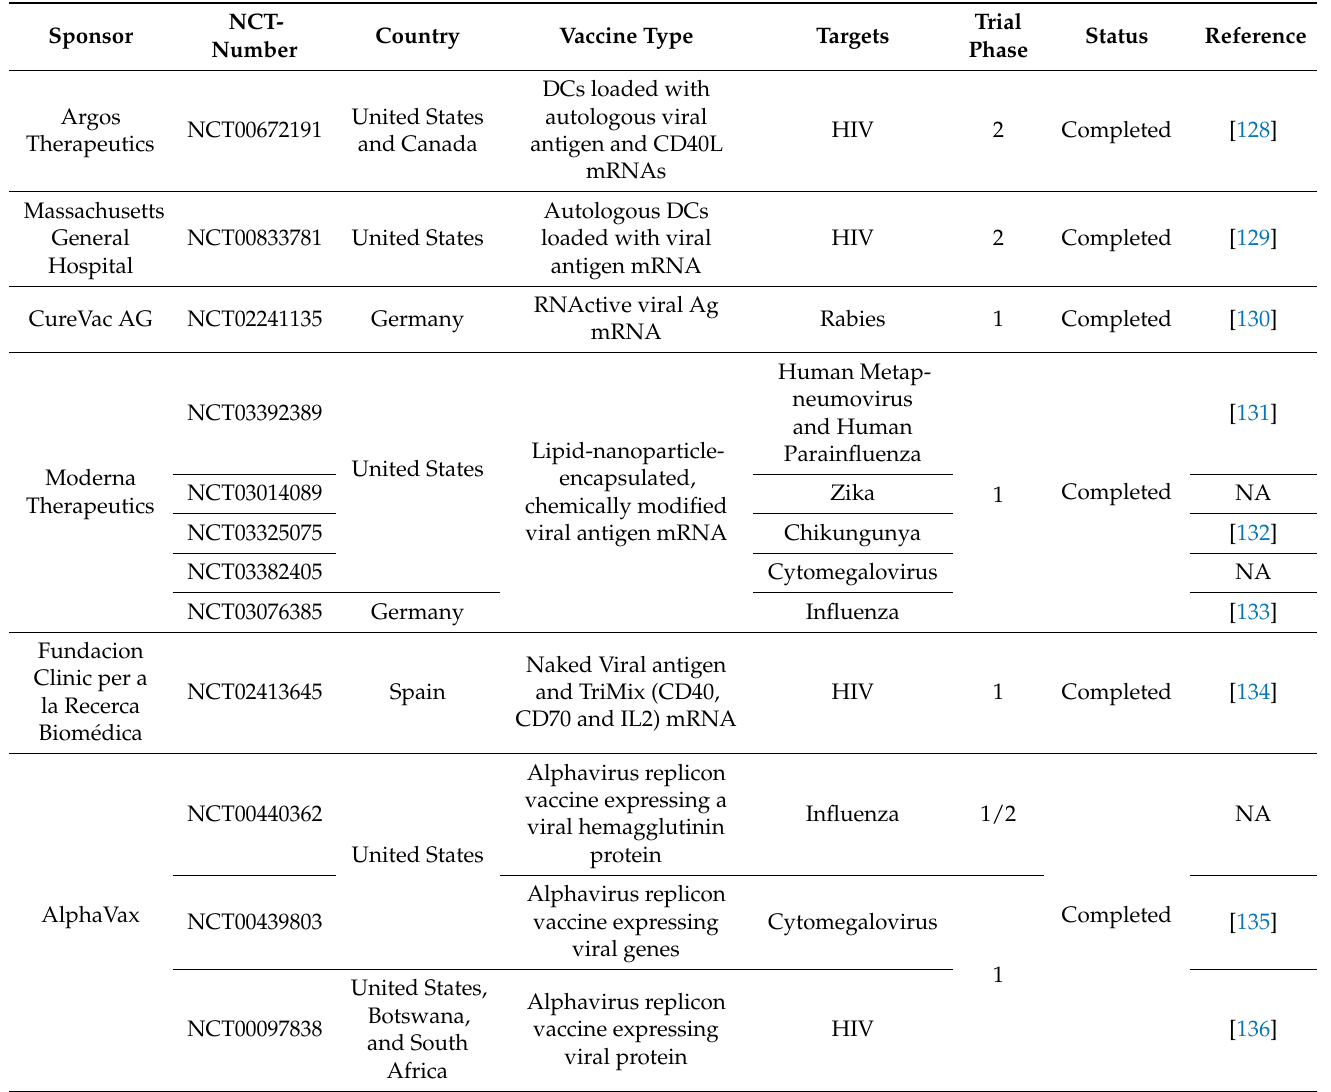
Table 2. Clinical trials with RNA-based vaccines against infectious diseases. Data collected from the studies registered at ClinicalTrials.gov as of 8 August